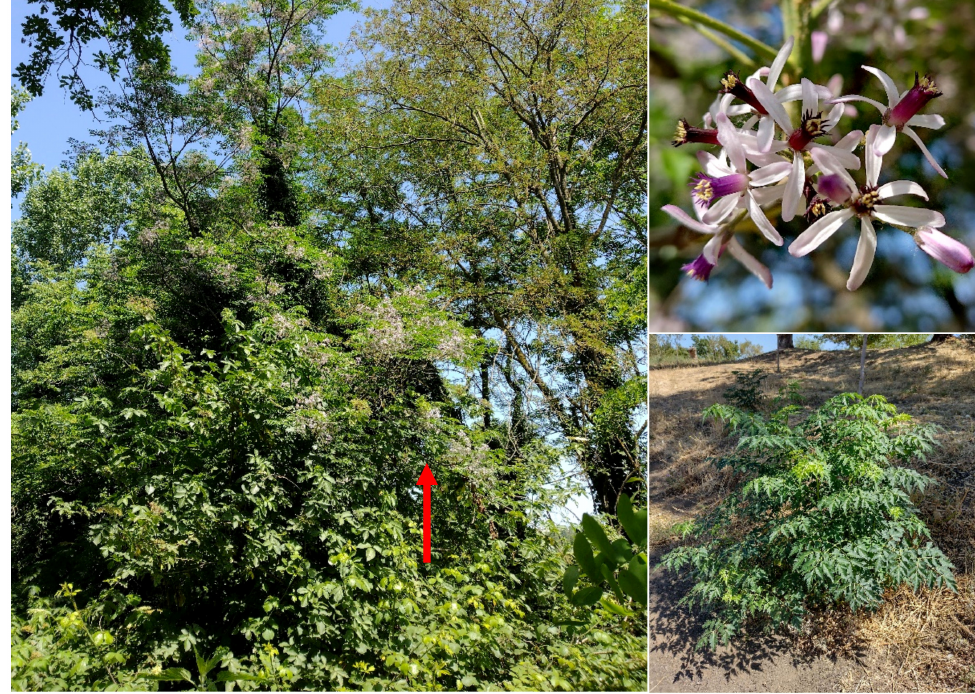
Figure 55. Melia azedarach (red arrow) in Caffarella valley (left and top-right photos); young individual in Acquedotti locality (bottom-right